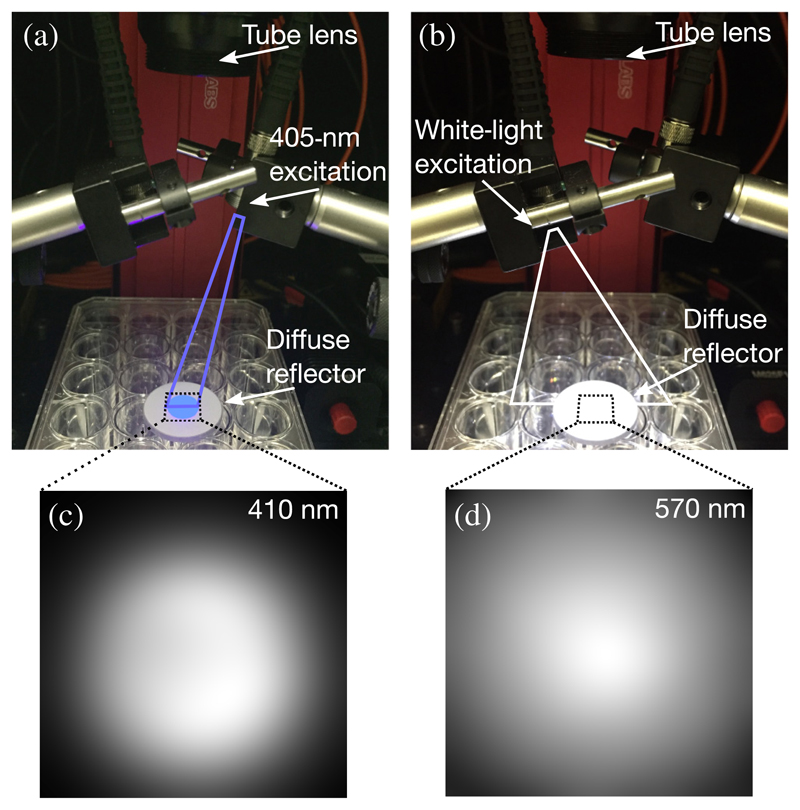
Experimental setup of obtaining reference diffuse reflectances Rref,ex(λ) and Rref,em(λ) under (a) UV excitation and (b) white-light excitation where both the illuminations are not perpendicular to the sample surface. (c) Measured diffuse reflectance at 410 nm on the diffuse reflector showing a heterogeneous distribution over the UV-illuminated area and (d) measured diffuse reflectance at 570 nm illustrating a heterogeneous distribution over the white-light illuminated area.